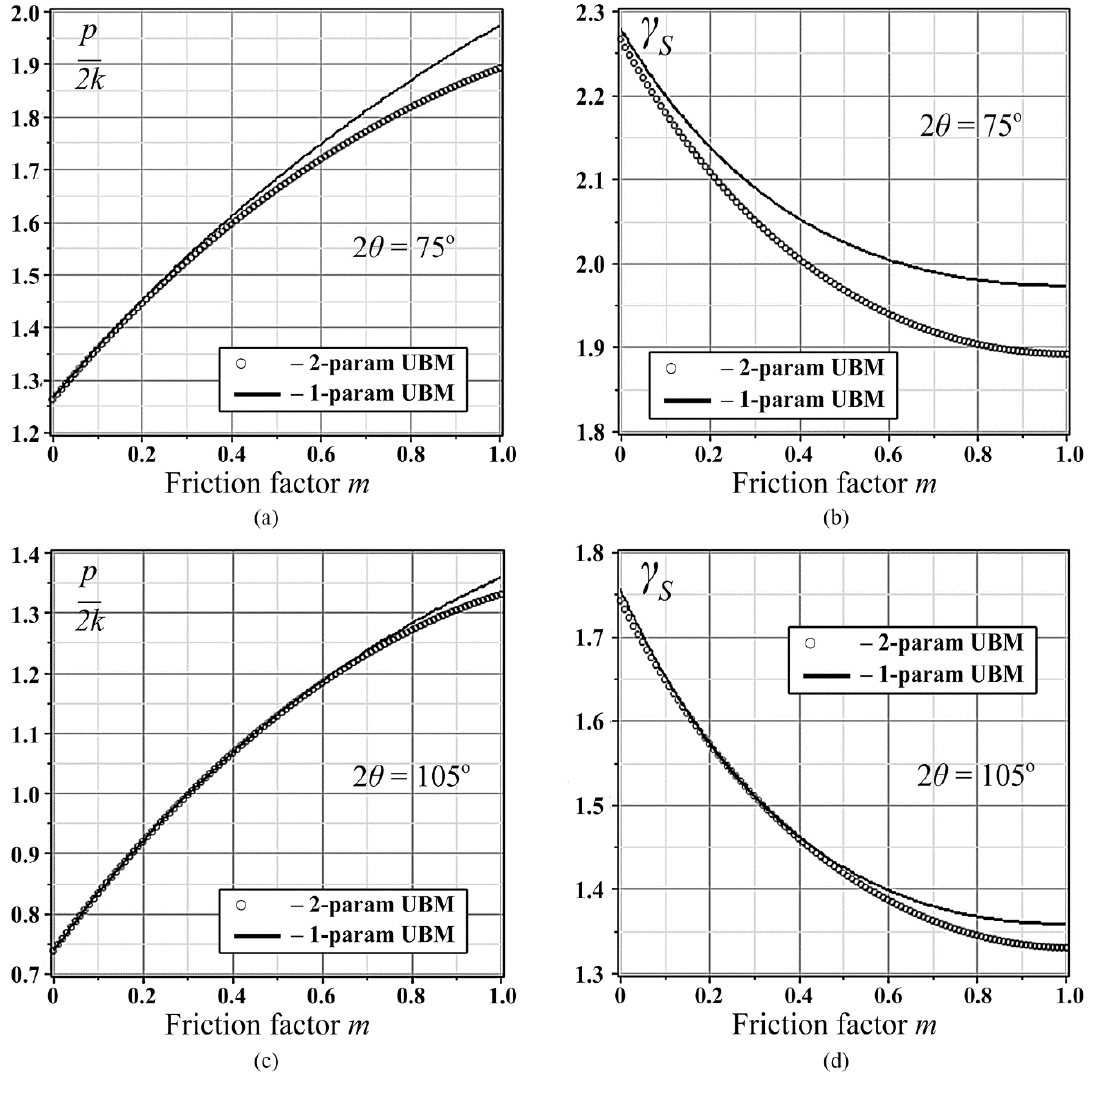
(b, d) with respect to friction S